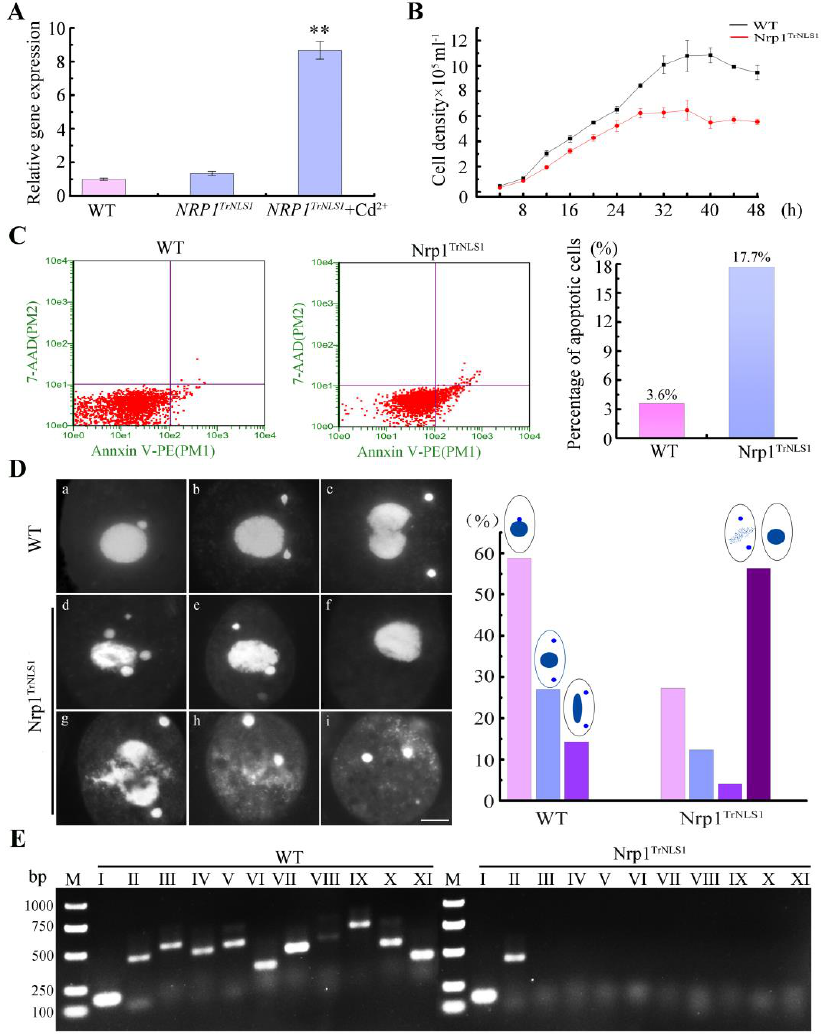
Figure 2. Proliferation and nuclear development of Nrp1 TrNLS1 mutants. ( A ) Relative expression level of NRP1 TrNLS1 . Total RNA was isolated from cells in the vegetative growth stage. The relative expres- sion level of NRP1 was identified by qRT-PCR. Data were analysed statistically by independent